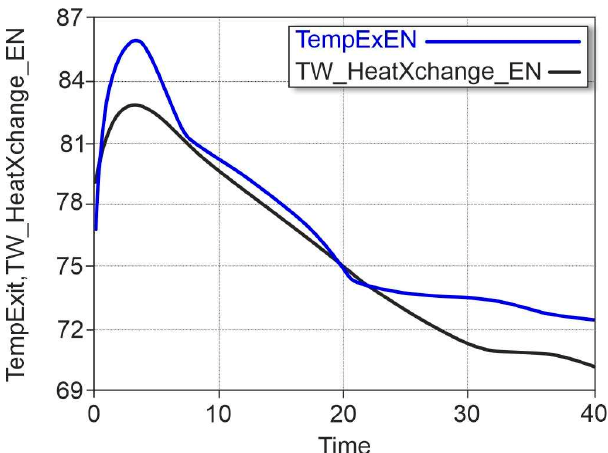
Figure 9. The heat flux in the system loop and in the feedback line during blood warming at the output of the EN model: TW_HeatXchange_EN—change in heat flow in the system circuit; TempExitEN—change in heat flow in the feedback line. The use of the temperature control scheme for the heat exchanger of the heart-lung machine allows for the minimizing of the heat flux gradient in the system circuit (TW_HeatXchange_EN) and in the feedback line (TempExitEN) when the blood is